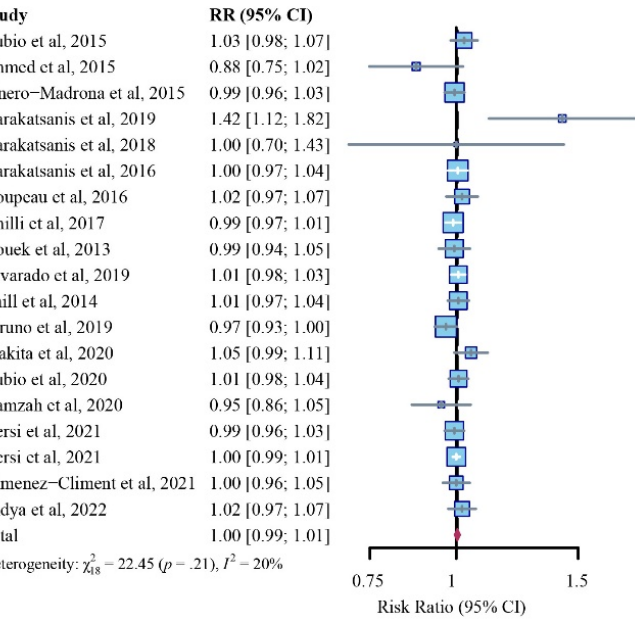
Figure 2. Relative risk (RR) analysis of patient identification rates for SPIO versus standard method (fixed-effects model).